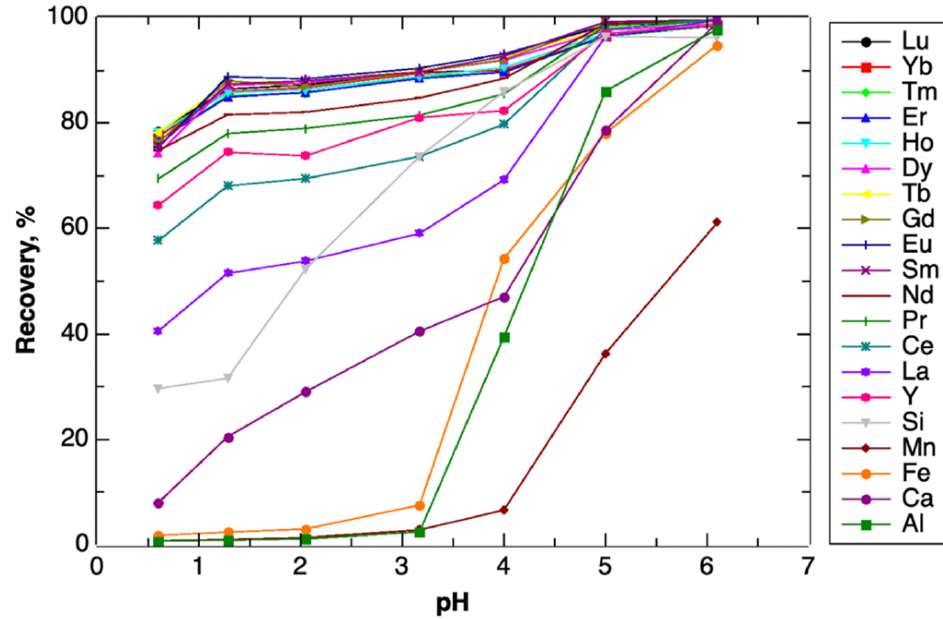
Figure 7. Effect of pH on elemental recovery of rare earth elements and contaminants (Al, Ca, Fe, Mn, Si) at a fixed dosage of 15 g/L and reaction time of 1 h.